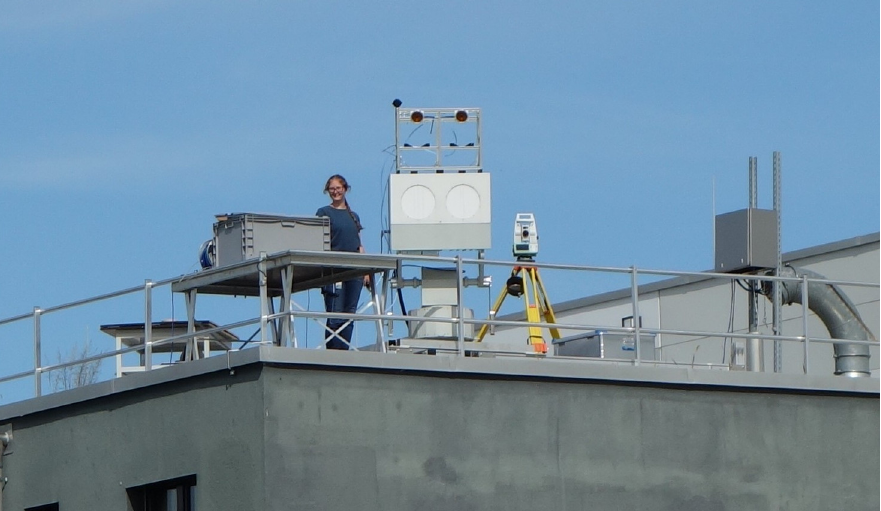
Figure 2. Photo of the elevated measurement set up located on the top of a building. The VNA is placed in a temperature-controlled box on the left on a table with its antennas (orange radoms) on top of the transponder (white and gray box on a positioner unit). The geodetic total station is placed on a wooden tripod right of the